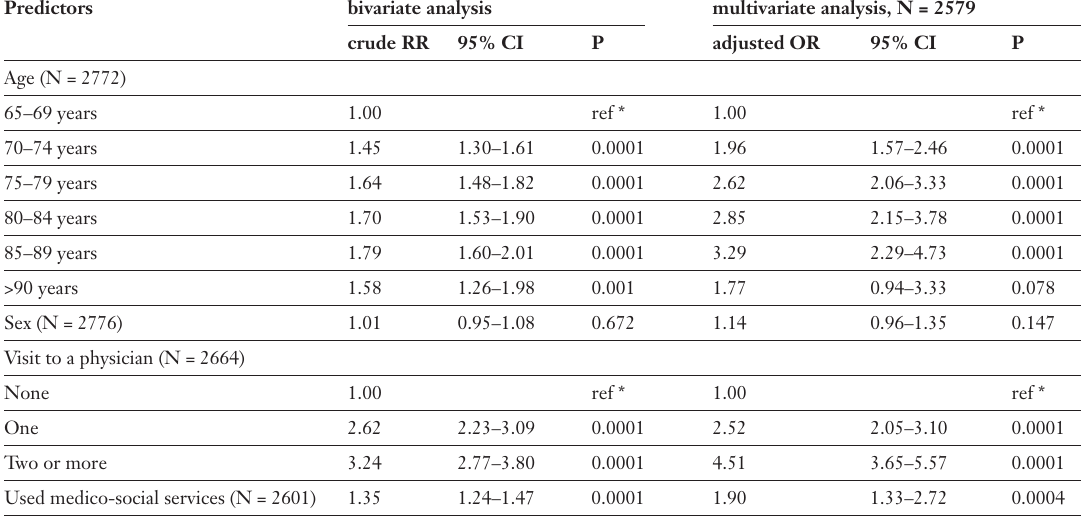
Survey 2000: Bivari- ate and multivariate analyses, predictors of influenza vaccina-